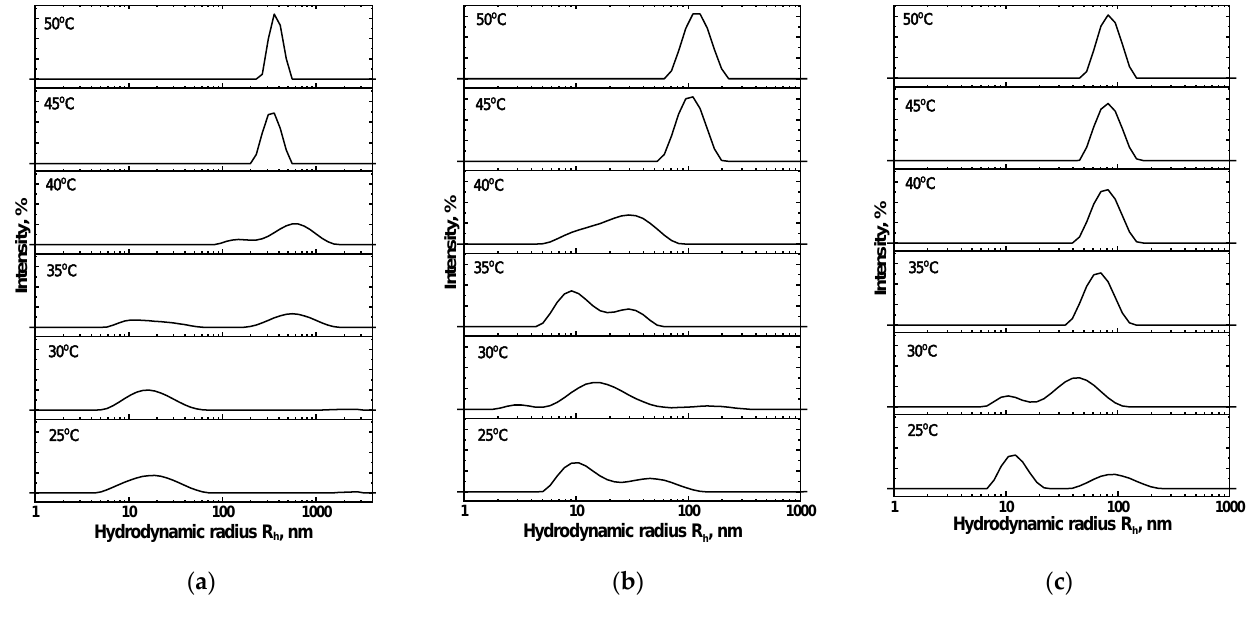
Figure 8. Effect of temperature and ionic strength (μ) on the mean hydrodynamic radius (R h ) of NIPAM90-APTAC5-AMPS5: μ = ( a ) 0.001, ( b ) 0.1 and ( c ) 1.0.